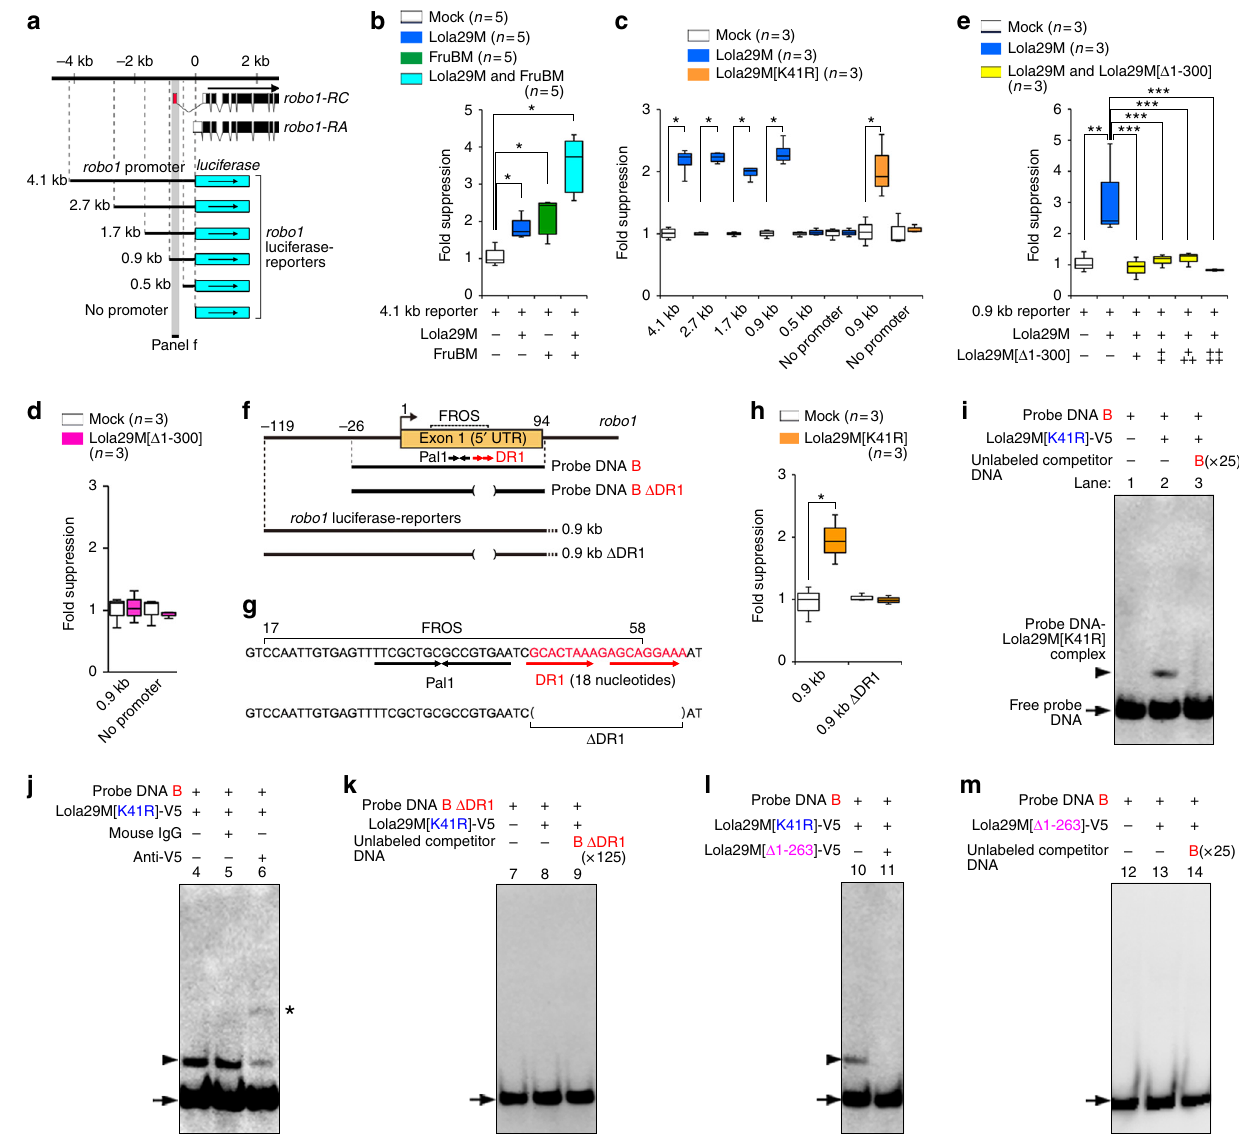
Fig. 5 Lola29M/F molecular actions. a – h robo1 promoter-luciferase reporter assays. a The robo1 genomic map (upper) and reporter schematics (lower). The genomic distance (in kb) is indicated on the top with the reference point 0, at which the robo1 genomic fragment was fused with the luciferase-coding sequence (blue box with an arrow). Below the thick line, the exon (box)-intron (thin line) organization of robo1 is shown. Filled and open portions of the box represent the coding and non-coding regions, respectively. b The relative activities (ordinate) of a 4.1 kb robo1 -promoter reporter cotransfected without (-) or with ( + ) Lola29M, FruBM or both. c The activities of reporters (ordinate) carrying a robo1- promoter fragment of different lengths (the fragment length is indicated on the abscissa) with ( fi lled bars) or without (open bars) cotransfection of Lola29M or truncation-resistant Lola29M[K41R]. d The reporter activities were unaffected by cotransfection with Lola29F-like (Lola29M[ Δ 1-300]). e The suppression effect of Lola29M on reporter activities was inhibited by Lola29M[ Δ 1-300]. f – m Lola29M binding to the robo1 promoter. f Genomic fragments used for EMSA. Probe DNA B and Probe DNA B Δ DR1 are shown in an expanded scale in the second and third rows. Reporters are schematically illustrated at the bottom. Pal 1: palindrome sequence, FROS: the FruBM- binding region, DR1: direct repeat 1. g The sequence around DR1 and FROS. The deletion in the 0.9 kb reporter is also indicated. h The repressor action of Lola29M[K41R] on the 0.9 kb reporter with or without DR1. * P < 0.05 by the Mann – Whitney U test. i – m EMSA with fragment-B detected a retarded band (arrowhead) in the presence of truncation-resistant Lola29M[K41R] (lane 2), which was eliminated by adding the unlabeled fragment-B as competitors (lane 3). Mouse IgG had no effect (lane 5), whereas the Lola29M[K41R]-recognizing anti-V5 induced a super-shift (asterisk; lane 6). The Δ DR1 probe did not induce retardation (lanes 8). An arrow indicates free DNA. Lola29M failed to produce the retarded band in the presence of Lola29F (lane 11), which on its own, did not produce the retarded band either (lane 13). Source data are provided as a Source Data fi